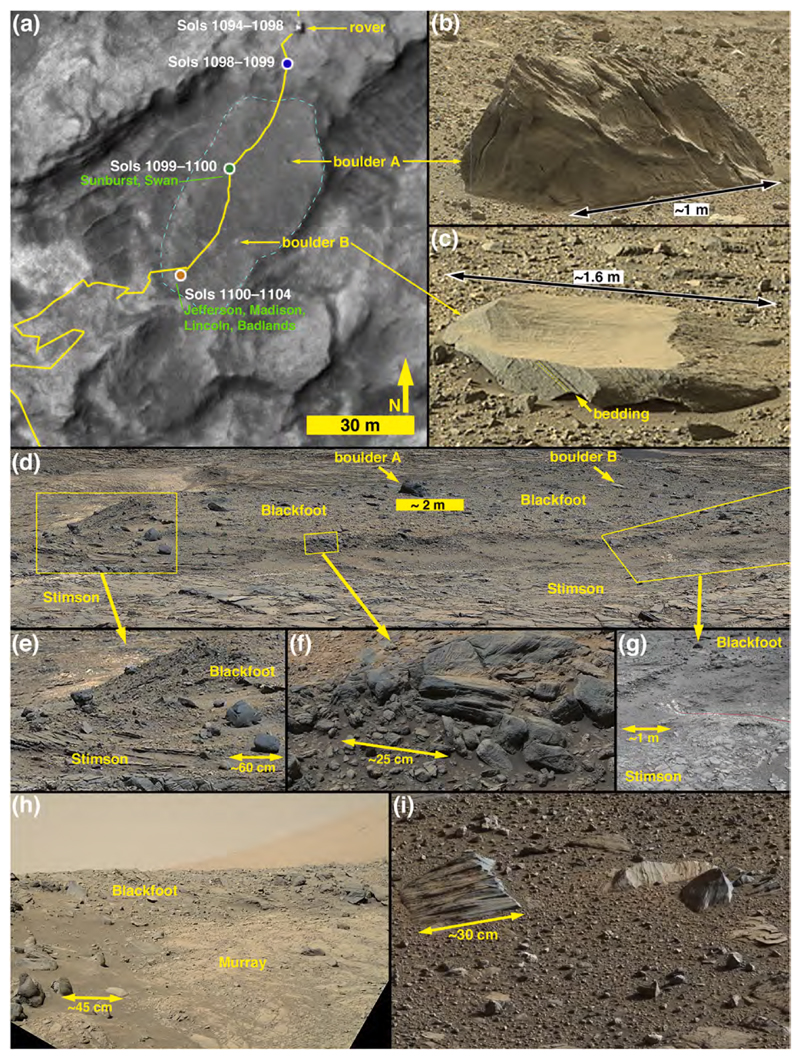
(a) The Curiosity rover and the Blackfoot heterolithic unit (within blue dashed outline) as imaged by HiRISE on 04 September 2015. Yellow trace indicates rover traverse, from north toward southwest. Locations of boulders A and B and the sites of two rover stops on Blackfoot are indicated. Locations of ChemCam targets Sunburst, Swan, Lincoln, Jefferson, Madison, and the APXS/MAHLI target Badlands, are indicated in green. (b) Boulder A is dark-toned when viewed from above; the rock is a dark gray sandstone and it has a surface that is rough at a centimeter scale. (c) Boulder B is light-toned when viewed from above (e.g. HiRISE images); the rock is a dark-gray sandstone; bedding is apparent; the skyward-facing surface is smooth at a centimeter scale and coated with eolian dust. (d) Blackfoot as seen from the north on Sol 1094 when the rover was parked at the position shown in (a). Boulders A and B and the locations of (e), (f), and (g) are indicated. (e) The north and east margins of the Blackfoot heterolithic unit overlie dark-gray, cross-bedded eolian Stimson-formation sandstones. (f) North edge of Blackfoot reveals the deposit in cross-section; here, it consists of a jumble of angular cobbles and pebbles; cobbles display a variety of orientations relative to their internal sedimentary structures (bedding). Dark-toned eolian sand has filled some of the gaps between stones. (g) Many of the open fractures which cut through Stimson-formation sandstones exhibit a light-toned, fracture-parallel, altered zone (a “halo;” see Frydenvang et al., 2017 and Yen et al., 2017). Here a fracture and associated halo follow the red trace and are abruptly truncated where covered by the Blackfoot heterolithic unit; this indicates that the fracture and fluids responsible for the “halo” alteration did not penetrate the Blackfoot deposit; i.e., one of the indicators that the deposit is not a lithic unit. (h) At its west-southwest end, the Blackfoot unit directly overlies mudstones of the Murray formation. (i) The cobbles and boulders of Blackfoot display a range of orientations, relative to their internal structure (bedding). Some of them protrude from the surface, others rest on the surface. (For interpretation of the references to color in this figure, the reader is referred to the web version of this article.)